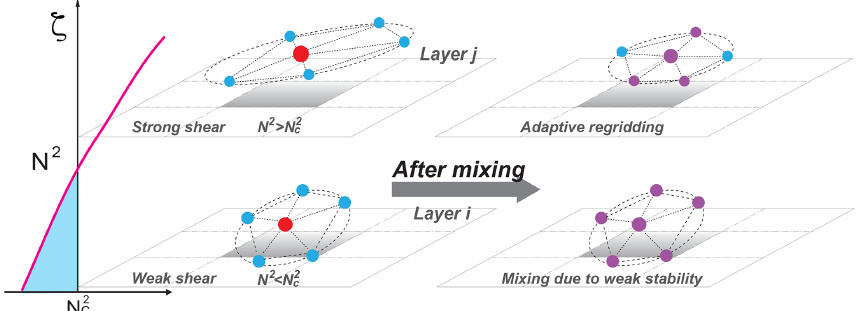
Figure 3. Mixing driven by vertical instability and strong wind shear. The profile on the left side is an idealized N 2 profile derived from the reanalysis and interpolated on the CLaMS air parcels (red). The lower part is representative for the troposphere with N 2 < N 2 c and the upper part for the stratosphere with N 2 > N 2 c . Thus, in the lower layer static stability is weak with the opposite configuration in the upper layer where, in addition, the wind shear is strong. In the upper layer, adaptive regridding is used to include mixing between a subset of the nearest neighbors of the considered air parcel (default mixing in CLaMS). In addition, in the lower layer, all nearest neighbors will be mixed with the considered air parcel if criterion N 2 < N 2 c is valid. The purple parcels are mixed parcels of red and blue parcels.